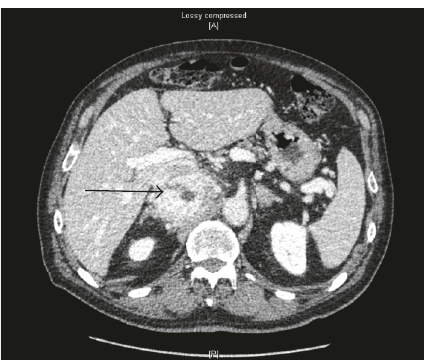
Figure 1: CT scan findings. 6.4 cm × 5.9 cm × 6.6 cm right retroper- itoneal mass posterior to the retrohepatic inferior vena cava (arrow).